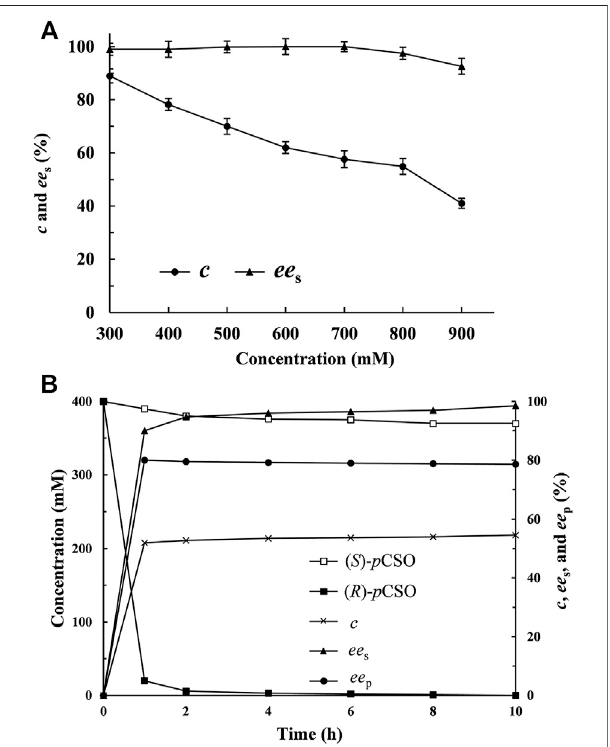
FIGURE 3 | The kinetic resolution of rac-p CSO by E. coli / rpeh F361V . (A) the hydrolytic reactions of rac - p CSO at 300 – 900 mM in the 4% (v/v) Tween- 20/phosphate buffer system (100 mM, pH 7.0) using 40 mg/ml wet cells of E.coli / rpeh F361V at25 ° C. (B) processcurvesofvariousparametersinthe scale-up kinetic resolution of 800 mM rac - p CSO at 25 ° C within 10 h.